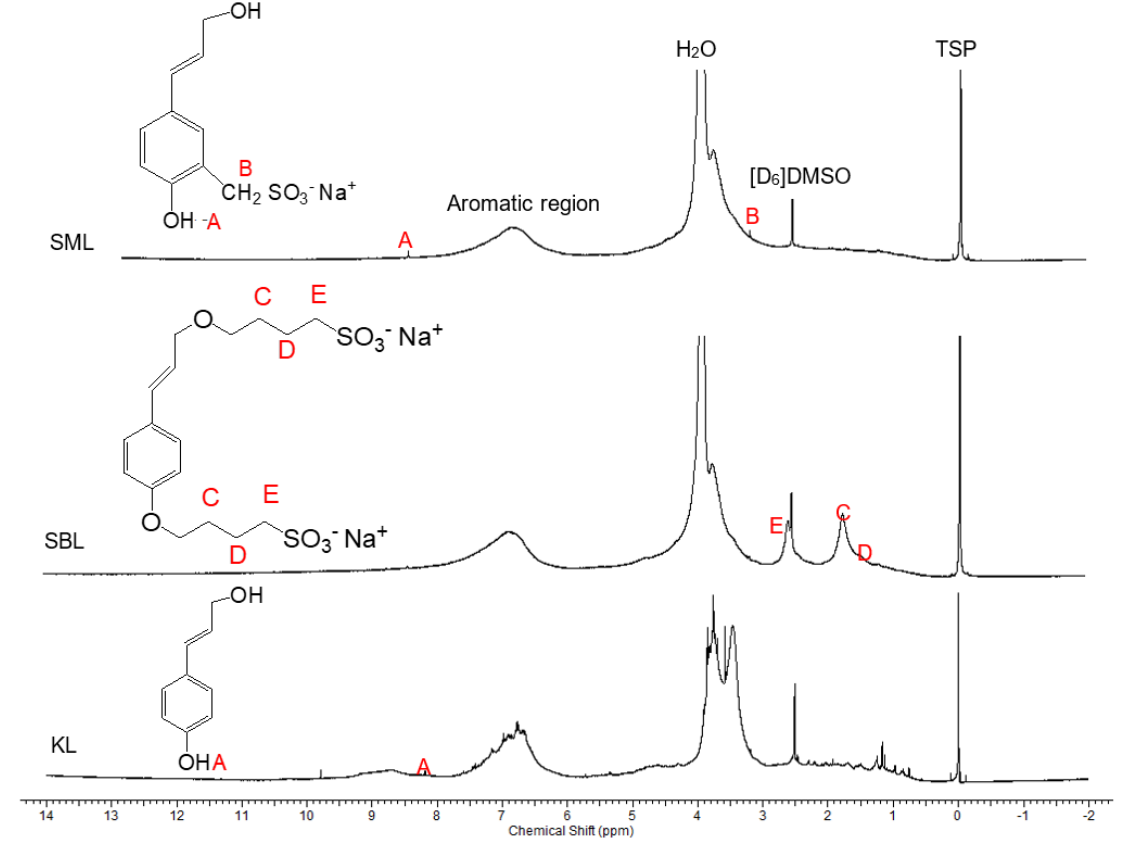
Figure 3. 1 H–NMR Spectra of kraft lignin (KL), sulfomethylated lignin (SML), and sulfobutylated lignin (SBL) in [D 6 ]DMSO.